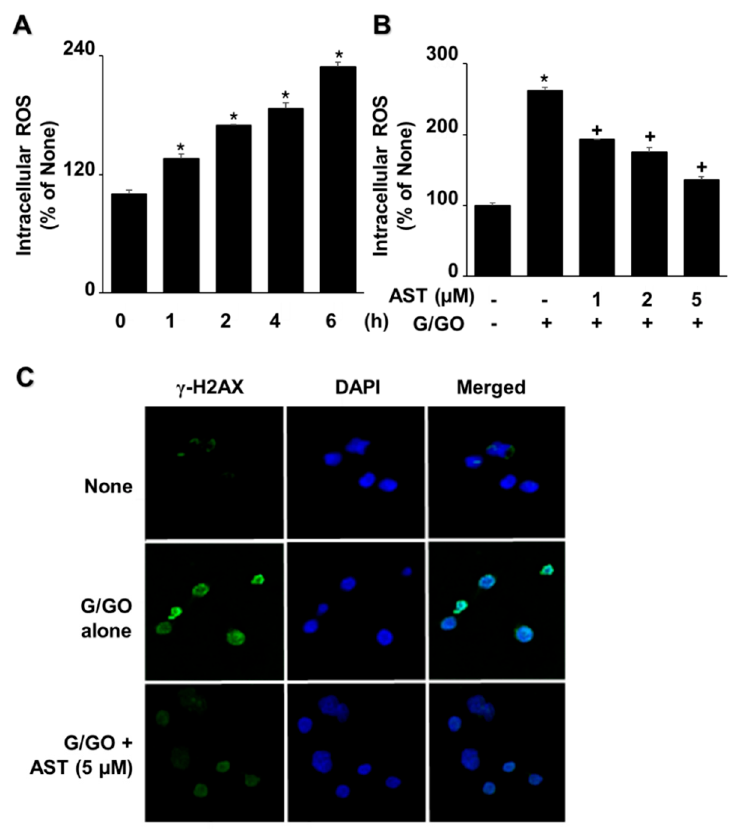
Figure 3. Astaxanthin inhibited the glucose/glucose oxidase (G/GO) − induced increase in reactive oxygen species (ROS) levels and γ -H2AX foci formation in AGS cells. ( A ) The cells were treated with G/GO for the indicated time periods. ( B ) The cells were pre-treated with the indicated concentrations of astaxanthin for 3 h and subsequently stimulated with G/GO for 6 h. ( A , B ) Intracellular ROS levels were determined using dichlorofluorescein (DCF) fluorescence. The value for ROS levels in untreated cells (AST − and G/GO − : cells without astaxanthin treatment, in the absence of G/GO) was set at 100%. All data are shown as mean ± standard error (SE) of three independent experiments. For each experiment, four samples were placed in each group (the total number in each group was 12). * p < 0.05 vs. untreated cells (AST − and G/GO − ). + p < 0.05 vs. control cells (AST − and G/GO + : cells without astaxanthin treatment in the presence of G/GO). ( C ) The cells were treated with 5 μ M astaxanthin for 3 h, followed by G/GO treatment for 16 h. Cells and nuclei were